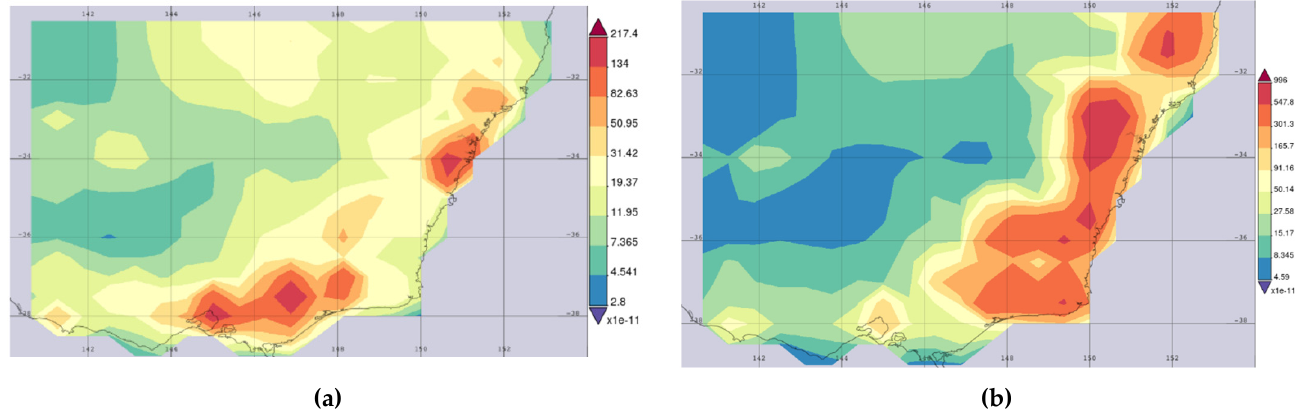
Figure 9. The average CO [kg/m 2 s] emission map on monthly basis over a wide range of periods, ( a )